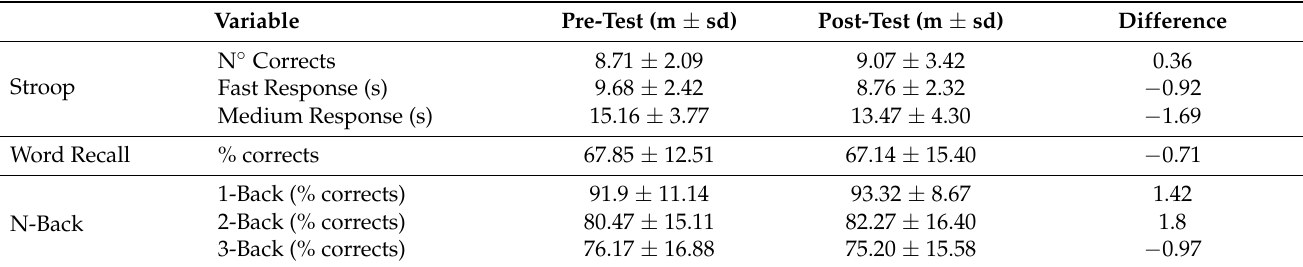
Table 2. Control Group. Descriptives of pre-test, post-test and differences.